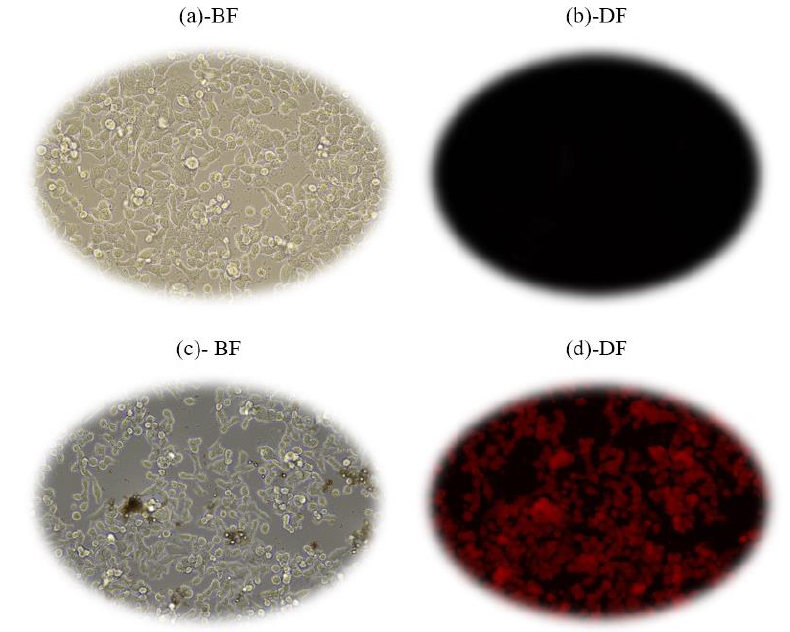
Figure 10. Fluorescent image of the HT29 colorectal cells without FOASET-IgG nanoparticles ( a ) in BF and ( b ) in DF, and with FOAET-IgG nanoparticles ( c ) in BF and ( d ) in DF.